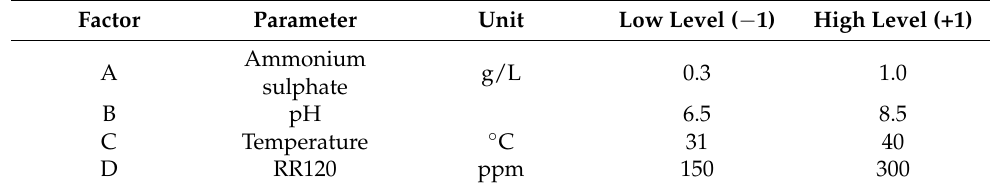
Table 3. Plackett-Burman design for tested factors.